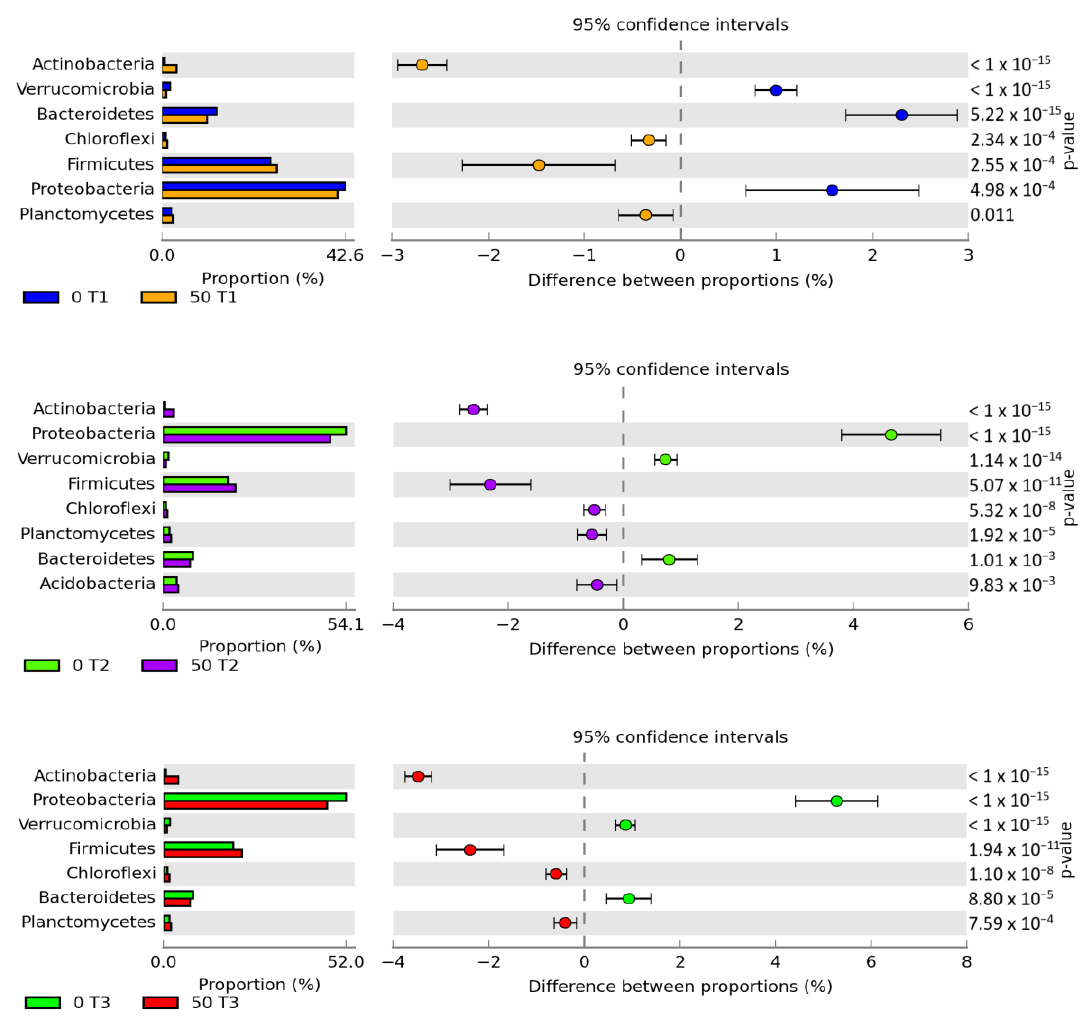
Figure 6. Relative abundance of the dominant bacterial phylum in soil with a difference between proportions ≥ 1%. A total of 0; 50—doses of o -cresol (mg kg − 1 DM of soil); T1—day 15, T2—day 30, T3—day 45 of the experiment.